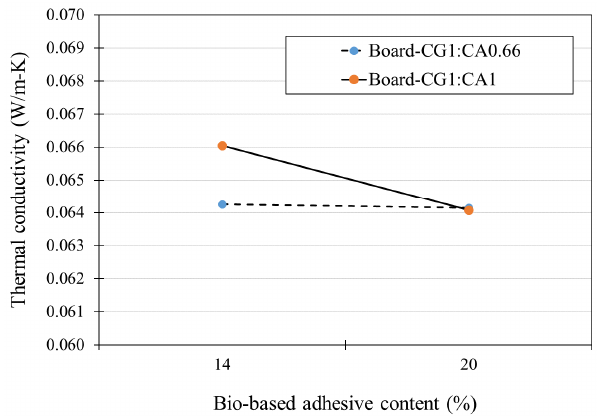
Figure 7. Interaction between the reactants’ ratio and the bio-based adhesive content in the thermal conductivity values of insulation board.